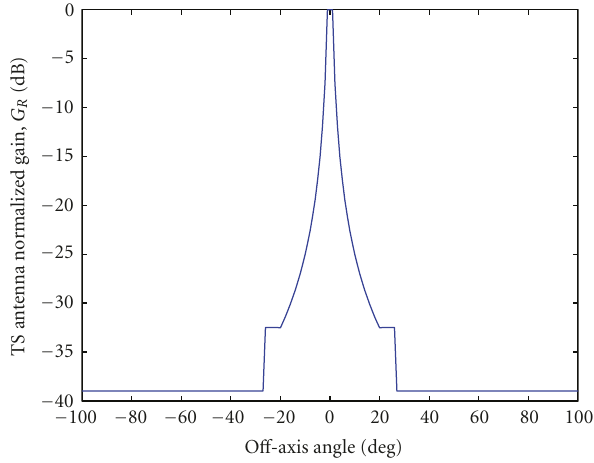
Figure 3: Spatial correlation coe ffi cient due to rain ρ 12 versus an- gular separation Δ θ for a dual-satellite MIMO channel operating in Atlanta, GA, at the Ka-band with satellite elevation angles φ 1 = 45 ◦ and φ 2 = 40 ◦